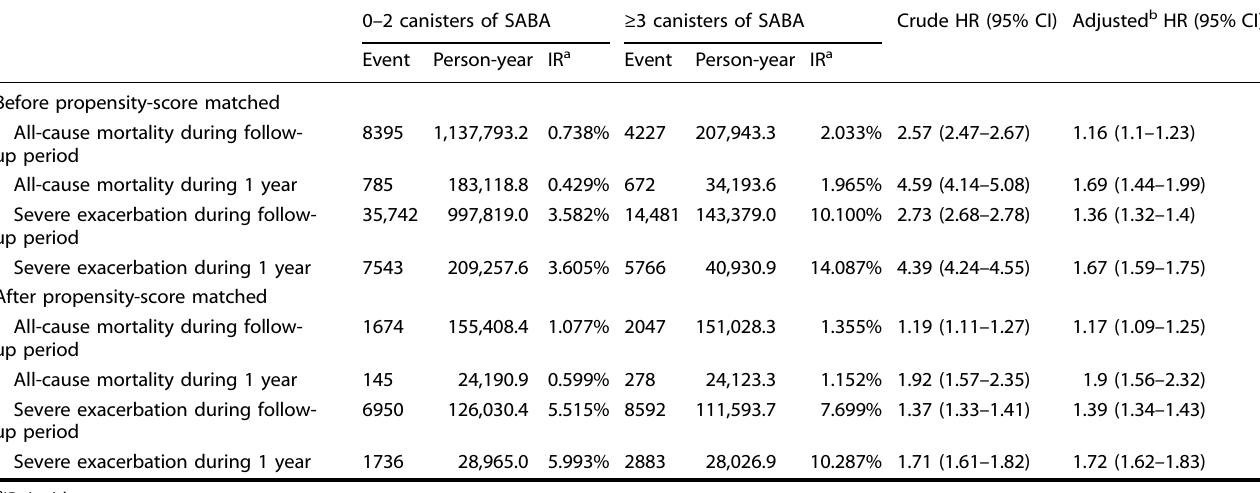
Table 6. Association between baseline short-acting beta-agonist (SABA) use and risk of all-cause mortality and severe